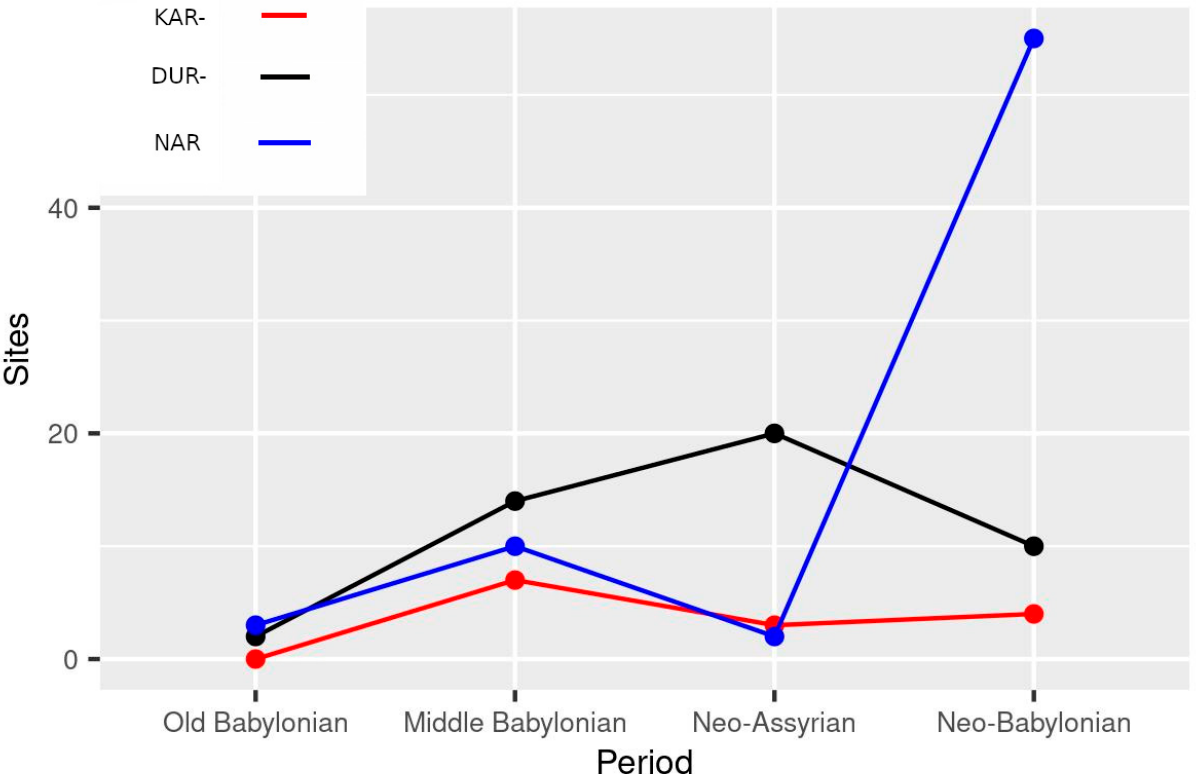
Figure 3. Place-name prevalence by period and type, after data compiled and digitized (Groneberg 1980, Nashef 1982; Bagg 2020, & Zadok 1985) [20–23].